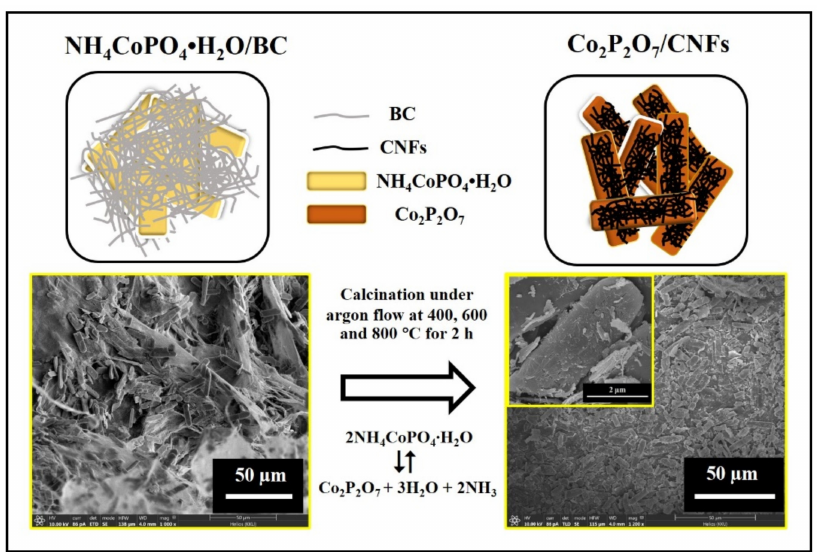
Figure 2. Schematic illustration with FE–SEM images for conversion of NH 4 CoPO 4 · H 2 O/BC aerogels to Co 2 P 2 O 7